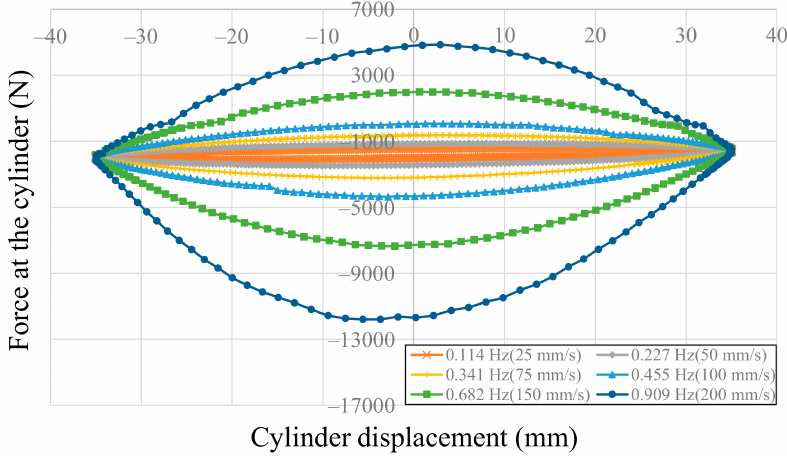
Figure 13. Force-velocity results from test when applied valve current was 540 mA (command 30%).